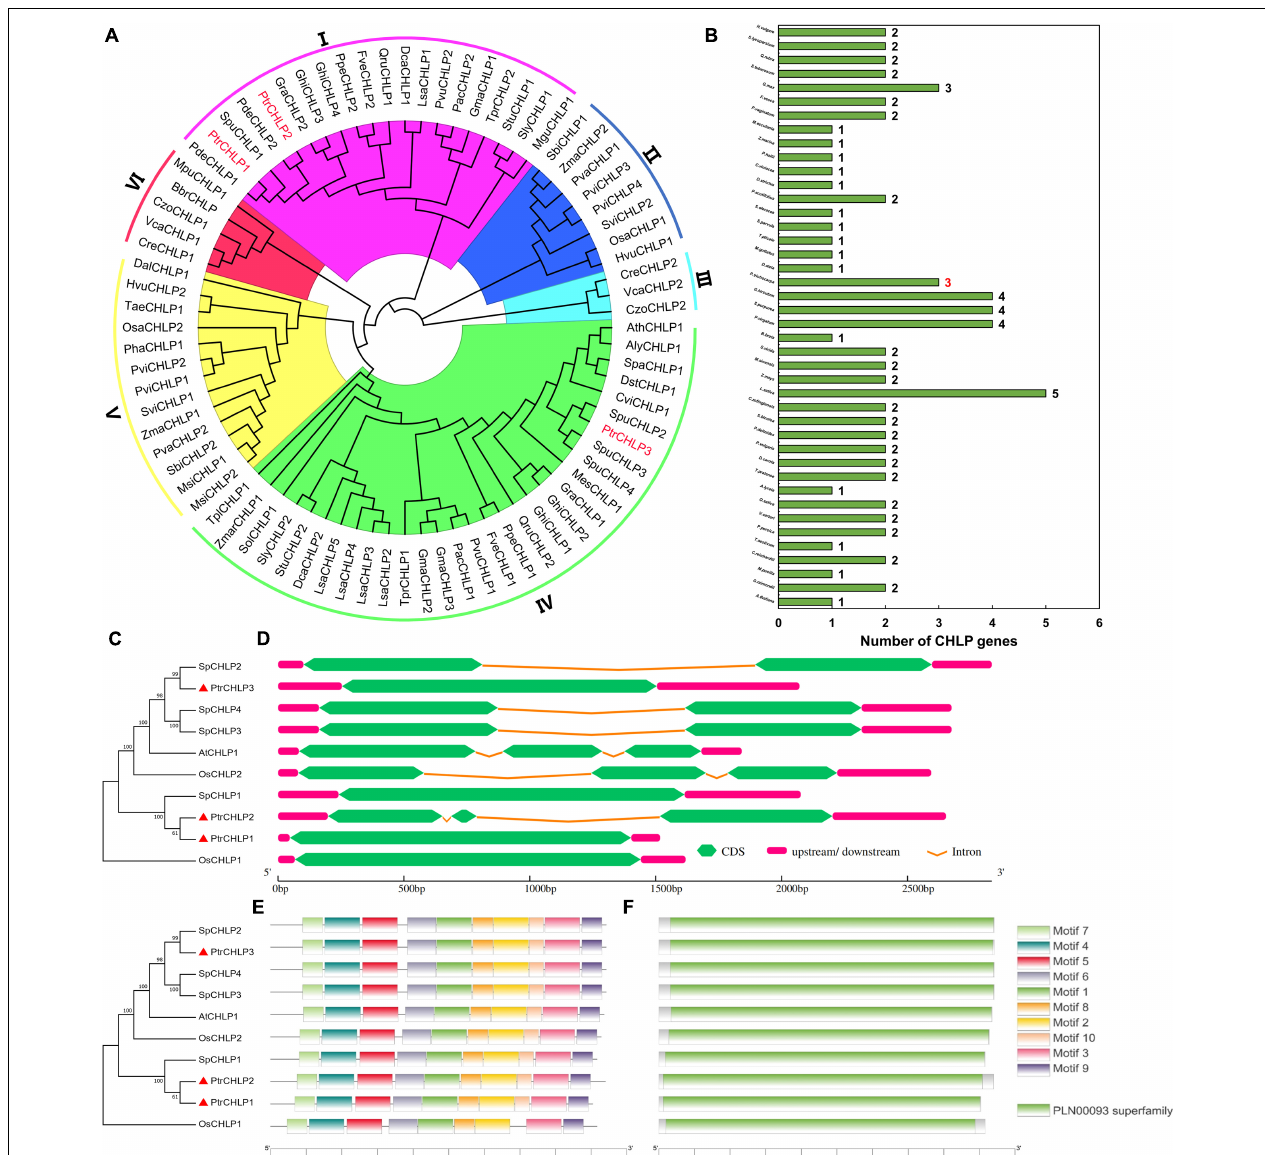
FIGURE 1 | The phylogenetic tree and molecular structure analyses of PtrCHLP . (A) Evolutionary and phylogenetic analysis of the CHLP family among different plants. (B) Comparisons of CHLP protein numbers across 42 plant species. The accession numbers and gene names are all shown in Supplementary Table S2 . The phylogenetic tree (C) , gene structure (D) , conserved motif (E) , and conserved protein structure (F) analyses of CHLP genes from A. thaliana , O. sativa , and P. trichocarpa . The length of each model is exhibited in proportion.